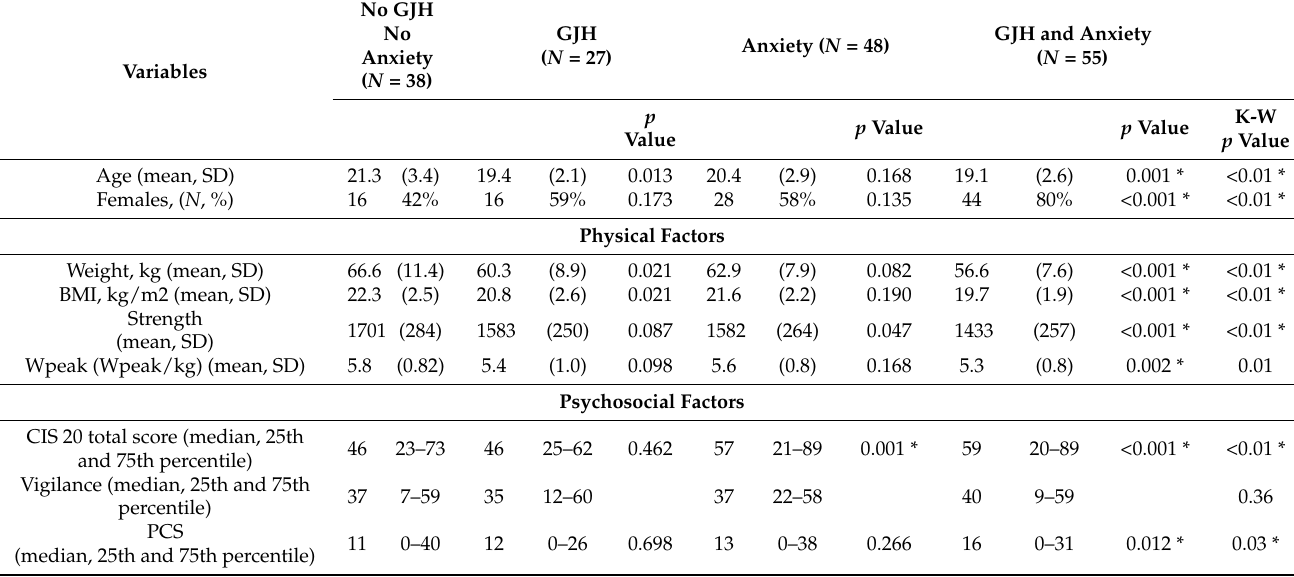
Table 2. Univariate analysis of scores on psychosocial and physical functioning in participants with anxiety and/or GJH and p values compared to participants of the No GJH No Anxiety group (Bonferroni